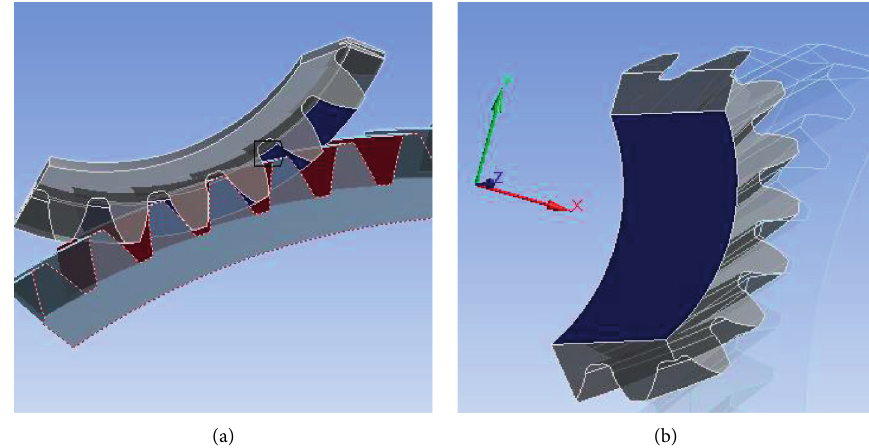
Figure 13: Boundary conditions of helical gears. (a) Helical gear contact pair. (b) The ground pair of helical gears.